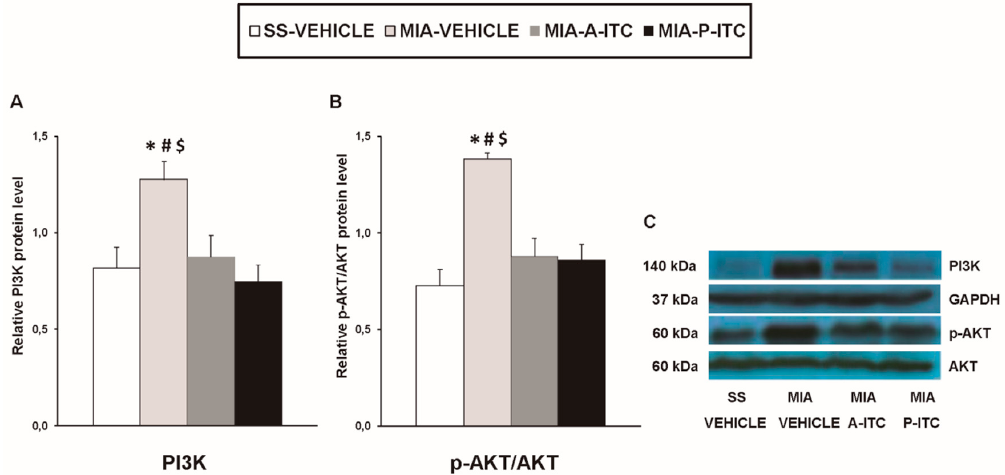
Figure 8. A-ITC and P-ITC treatments inhibit the overexpression of phosphatidylinositol 3-kinase (PI3K) and protein kinase B (p-Akt) in the hippocampus of mice with osteoarthritis pain. The